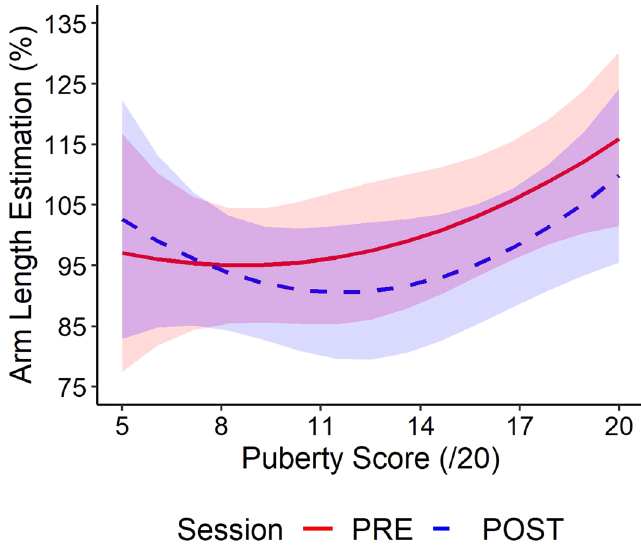
Figure 6. Arm length estimation in percent of actual arm length as a function of the puberty score. Most participants (puberty score > 9) estimated their arm as shorter after tool use.